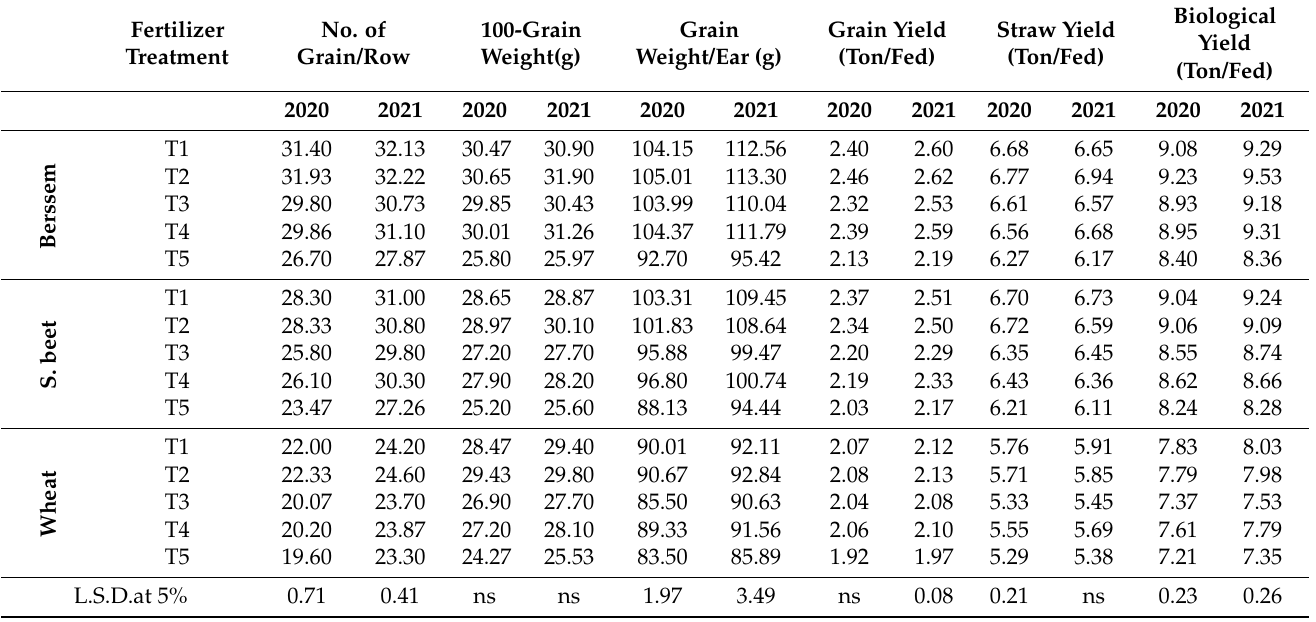
Table 6. The effect of interaction on maize yield and some of its components under intercropping system during 2019 and 2020 seasons.